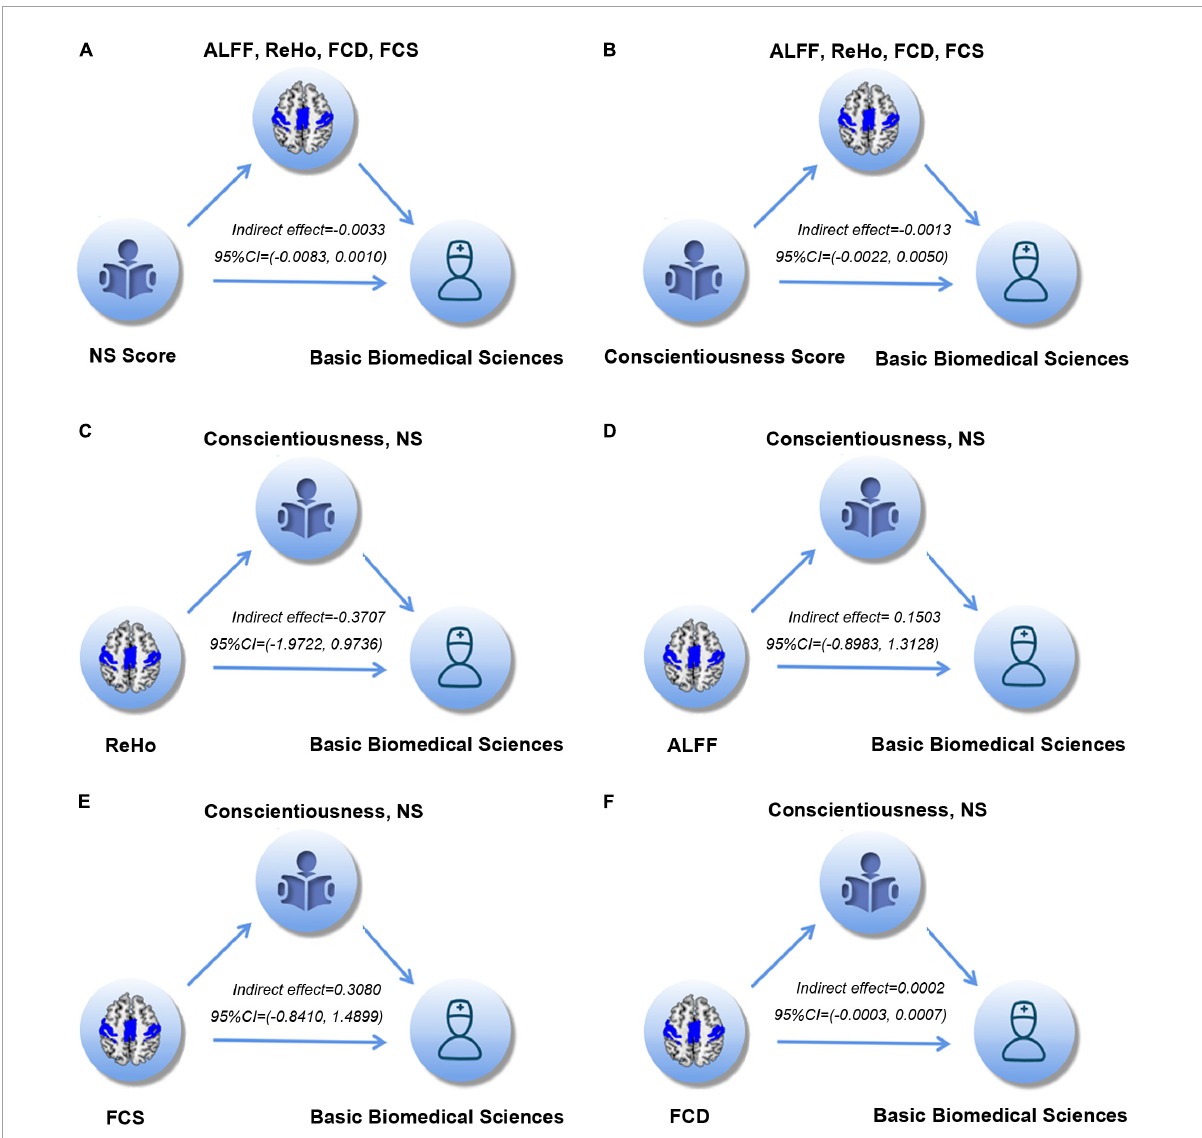
FIGURE4 (A–F) The multivariate mediation analyses of the associations among personality, brain functional properties and academic achievement of basic biomedical sciences. The indirect effects and their 95%CI were provided. NS, novelty seeking; ReHo, regional homogeneity; ALFF, amplitude of low frequency fluctuation; FCD, functional connectivity density; FCS, functional connectivity